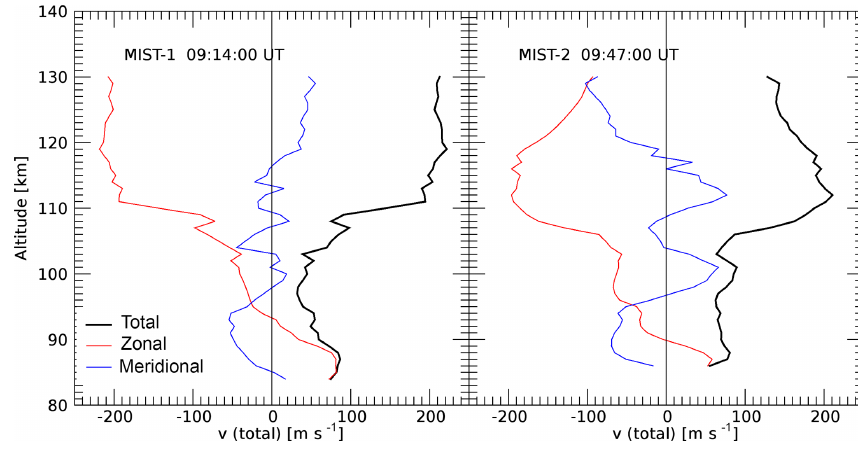
Figure 13. Horizontal winds derived from chemical trails.